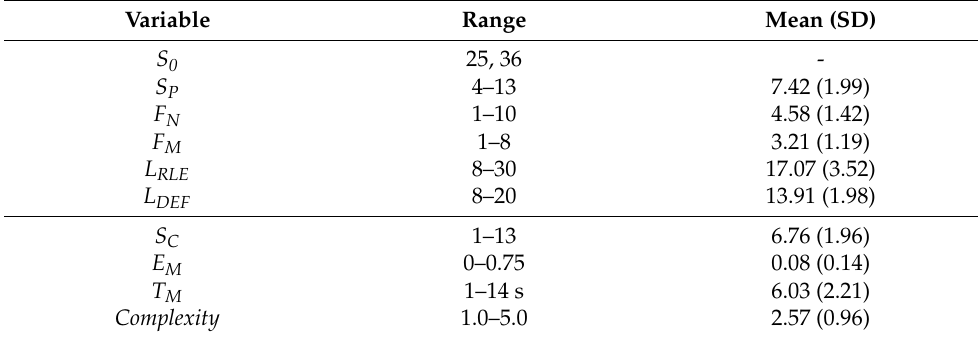
Table 1. Descriptive statistics for the variables in the experiment.